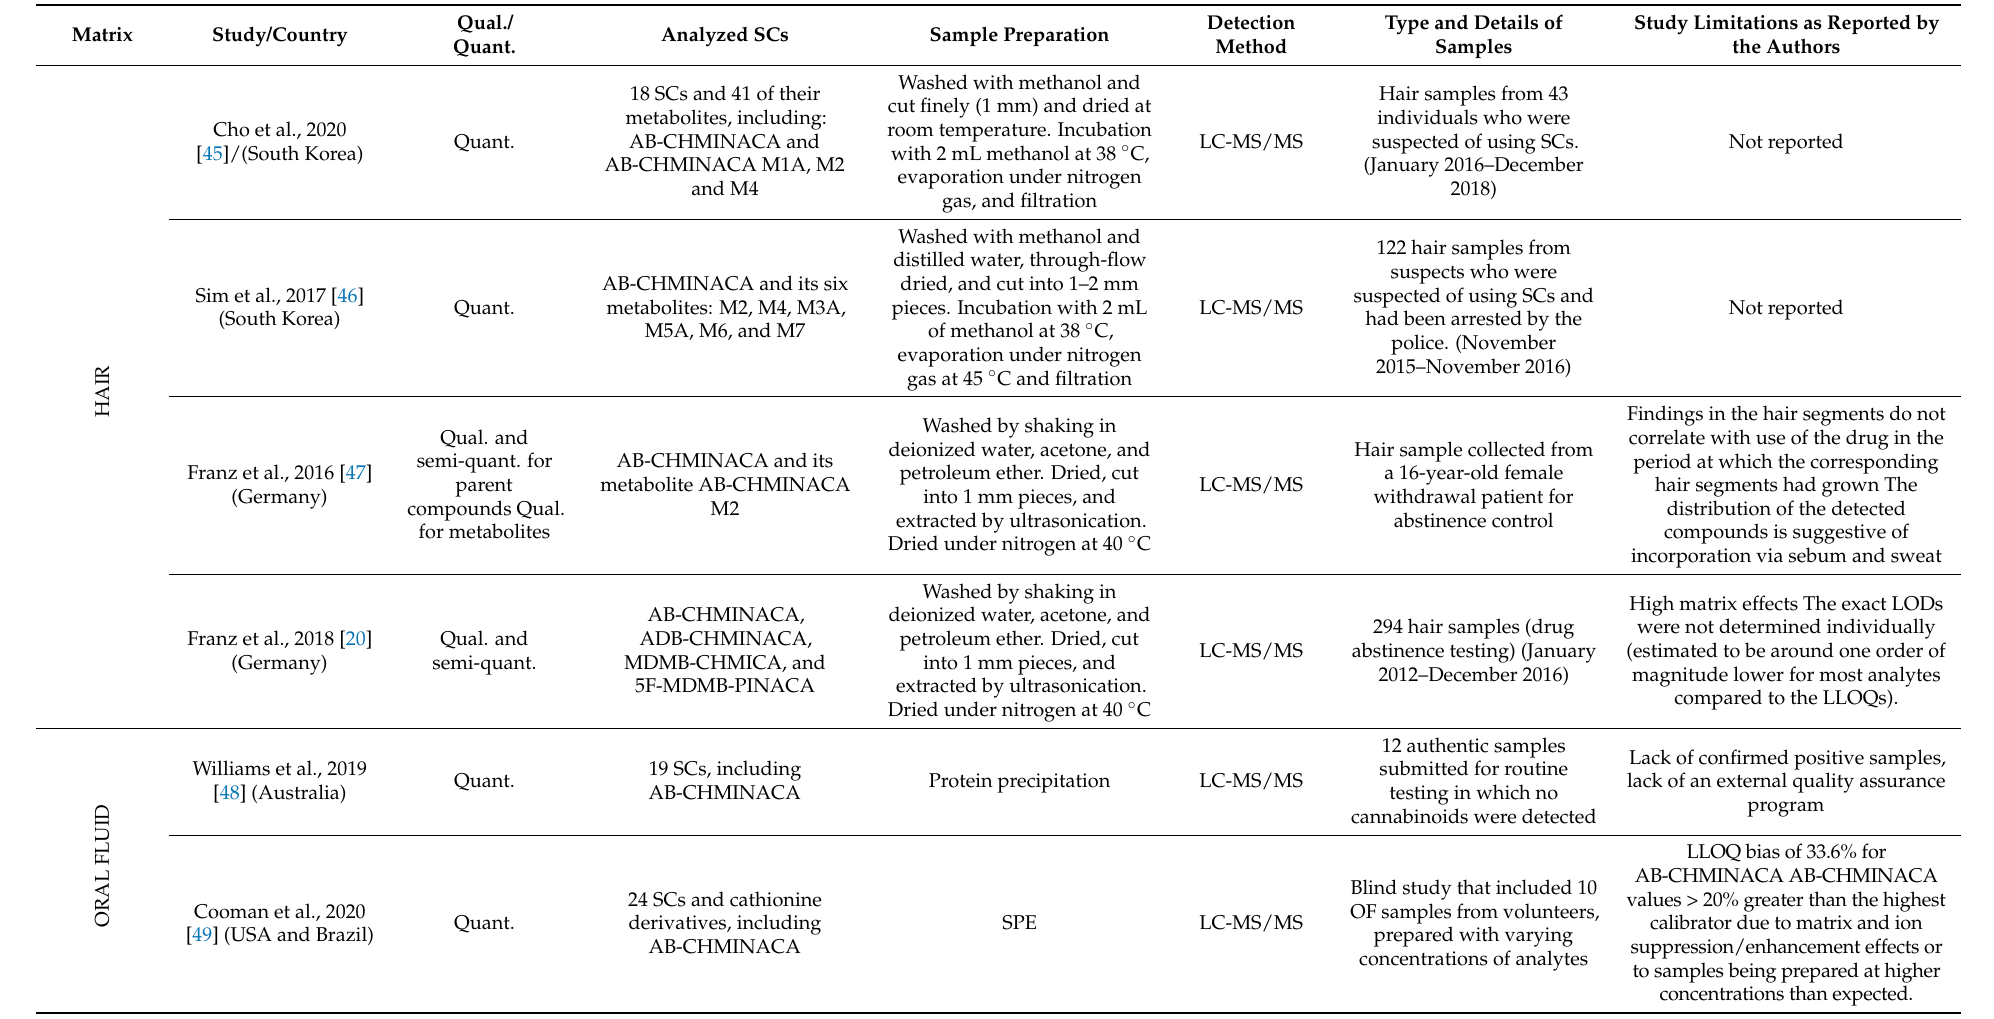
Table 2. Summary of the analytical methods for the identification of synthetic cannabinoids in biological